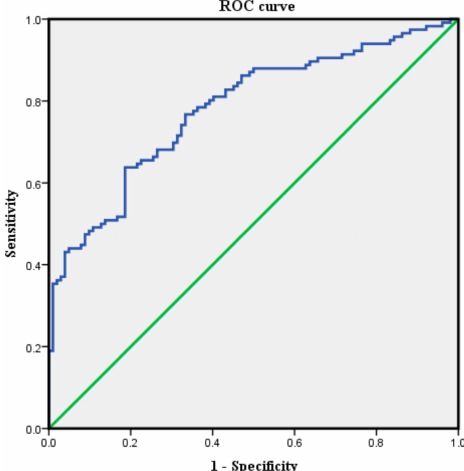
Figure 2. The ROC curve of the inferior articular process’s cross-sectional area for predicting central lumbar spinal stenosis (control group: 102 individuals, central lumbar spinal stenosis group: 116 patients). The best cut-o ff point was 75.88 mm 2 , with a sensitivity of 71.6%, a specificity of 68.6%, and an AUC of